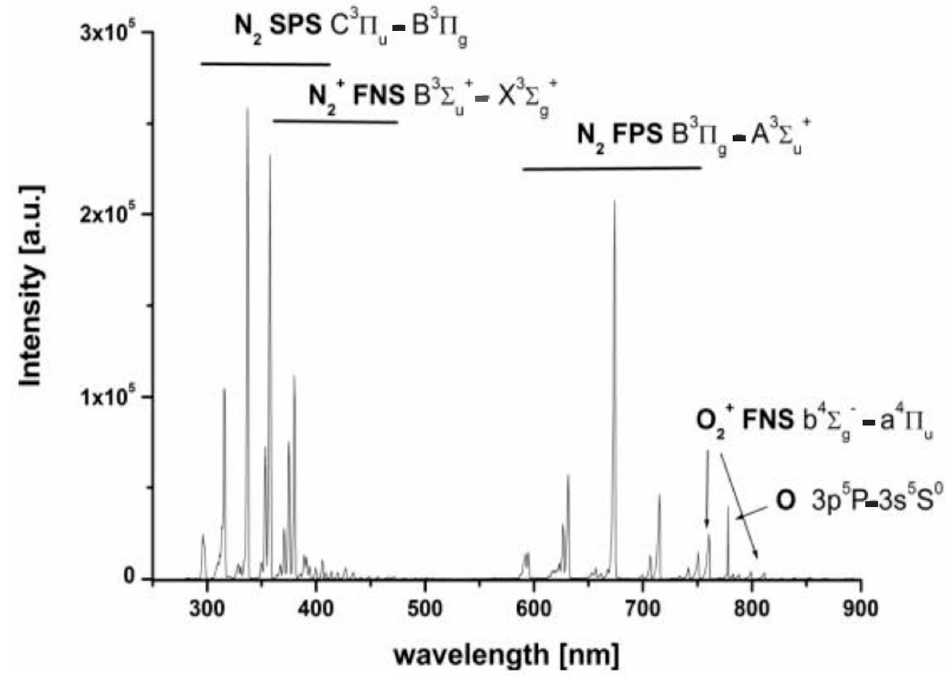
Figure 3. Emission spectrum indicating some of the radiative reactive species produced. With cover, the germination potential of broccoli seeds is smaller in all voltage cases, as can be seen from Figure 4a, similar to our previous work [39]. For processing periods of 60s and longer, the germination process is inhibited, especially for voltages higher than 10 kV, which corresponds to an approximate power density of about 0.03 W/cm 3 . Still, small but significant increase of the stem length of the sprouts was noticed for the 9 kV, 60s treatment and 10 kV, 30s conditions. For short exposure intervals, there is no linear correspondence between stem length or root length and voltage or discharge power (Figure 4b,c). With cover, the inhibition effects are much stronger than for direct treatment without cover, indicating a strong contribution of the reactive species.